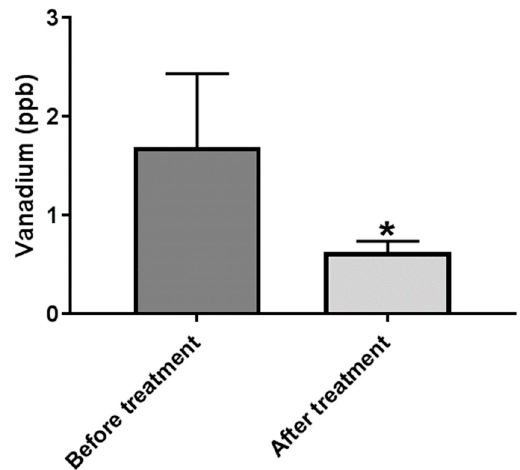
Figure 1. Vanadium concentration in the sera of BD patients before and after treatment. Blood samples were collected from the patients immediately upon admission due to a manic episode to Psychiatric Hospital. A second blood sample was collected 2–3 weeks later following initial stabilization and partial remission of the symptoms. Vanadium concentrations were determined in sera samples as described in Materials and Methods. The results are expressed as mean ± SEM, n = 11. The difference between the groups was analyzed using nonparametric Exact One ‐ tail Wilcoxon Signed ‐ Ranks Test. * significantly lower than before treatment, p < 0.05.